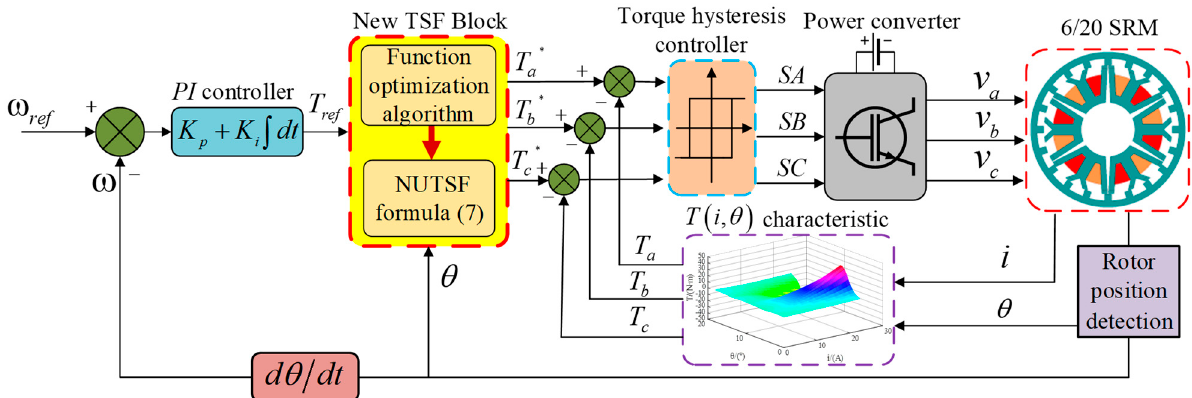
Figure 10. Block diagram of the proposed NUTSF.